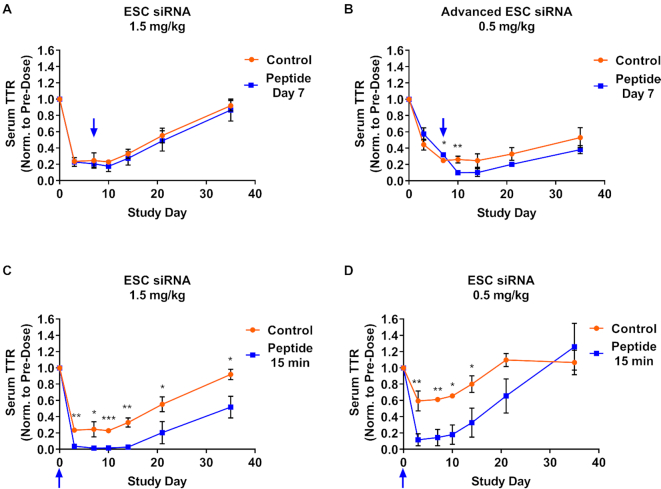
Functional siRNA can be liberated from acidic intracellular compartments by an endolytic GalNAc-peptide conjugate. Cohorts of control mice were dosed with an siRNA alone, either ESC (siTTR-1) or Advanced ESC (siTTR-3), targeting Ttr. Separate cohorts of mice were dosed with the same siRNA as control cohorts followed by the GalNAc-INF7 endolytic peptide at various time points. (A) siTTR-1 was dosed SC at 1.5 mg/kg in two cohorts of mice, one of those cohorts was also dosed with 5 mg/kg of the endolytic peptide at day 7 post siRNA dose. (B) siTTR-3 was dosed SC at 0.5 mg/kg in two cohorts of mice, one of those cohorts was also dosed with 5 mg/kg of the endolytic peptide at day 7 post siRNA dose. (C) siTTR-1 was dosed SC at 1.5 mg/kg in two cohorts of mice, one of those cohorts was also dosed with 5 mg/kg of the endolytic peptide 15 min post siRNA dose. Note the control siRNA group is the same in (A) and (C). (D) siTTR-1 was dosed SC at 0.5 mg/kg in two cohorts of mice, one of those cohorts was also dosed with 5 mg/kg of the endolytic peptide 15 min post siRNA dose. Serum TTR protein levels were monitored for 35 days post-dose. Blue arrows indicate endolytic peptide dose time. Data is represented as mean ± SD, for N = 3. Welch's independent t-test was utilized to compare the mean value between the control and peptide-treated groups at each timepoint to identify significant differences in target knockdown (*P ≤ 0.05, **P ≤ 0.01, ***P ≤ 0.001). Full results for the statistical analysis are included in the Supplemental Information.